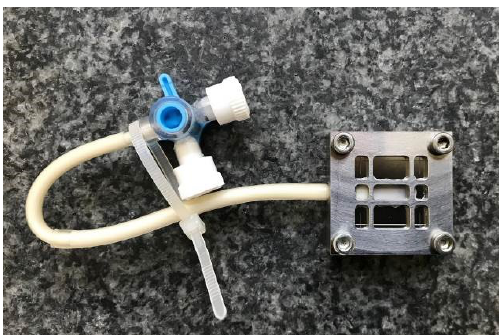
Figure 3. Thin-film thickness standard filled with lubricant with mounted glass and a cover plate as well as an inflow tube.